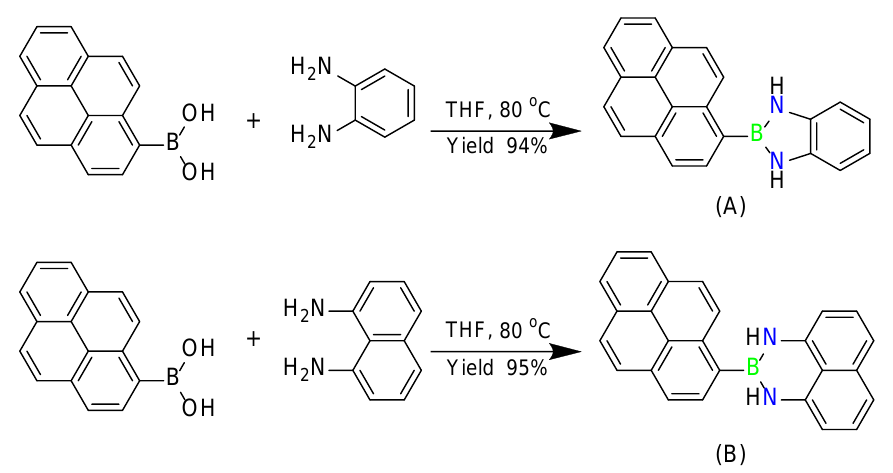
Scheme 1. The preparation of NBN-doped pyrene-containing PAHs ( A ) Py-NBN-Ph ( B ) Py-NBN- Naphth through intermolecular dehydration between boronic acid and diamine